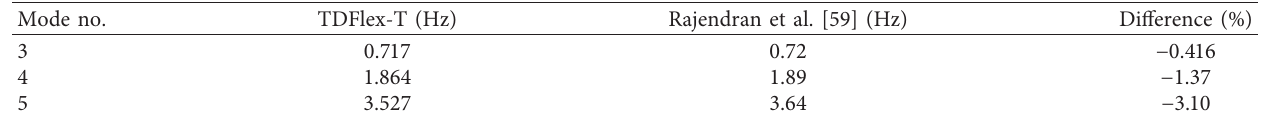
Table 5: Dry natural frequencies of the ULCS for vertical flexural